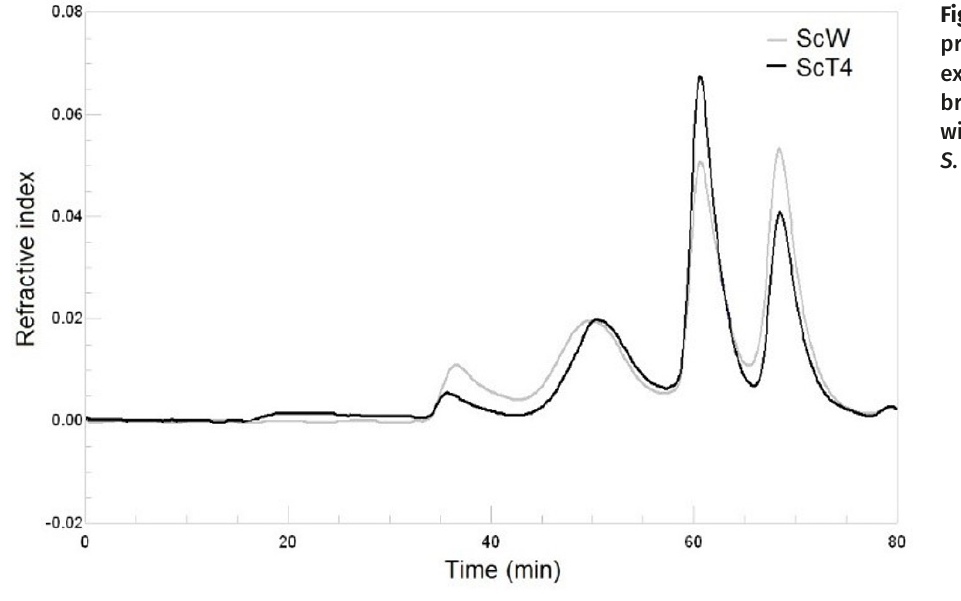
Figure 1. Elution profile of the fractions extracted from the broth and mycelium of wild (ScW) and mutant S. commune (ScT4).